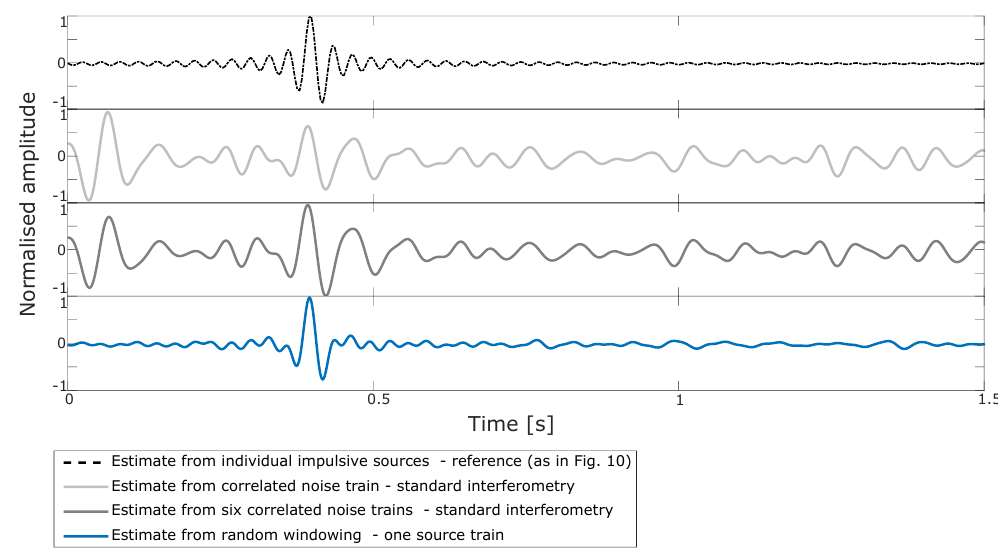
Figure 11. Waveforms corresponding to the estimated phases shown in the top-right panel of Figure 10, for correlated noise with source phases recorded at a perpendicularly oriented pair of receivers 400 m apart, with the medium speed set at 1000 m/s. For reference, the estimate calculated from individual point sources is depicted in black dashes ( top ), exhibiting the inter-receiver arrival at 0.4 s. The estimate produced by standard interferometry without stacking is shown in light gray ( second from top ). The waveform resulting from standard stacking of six estimates is depicted in dark gray ( third from top ). The estimate obtained from the random windowing method applied to a short recording of a single source is shown in blue ( bottom ).